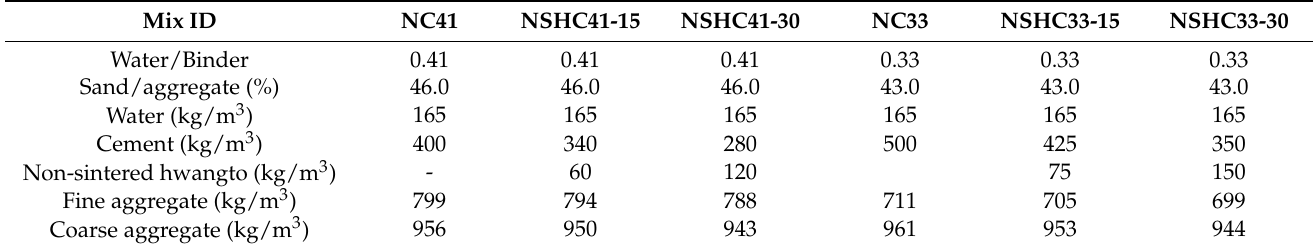
Table 4. Mix proportions of the NC and